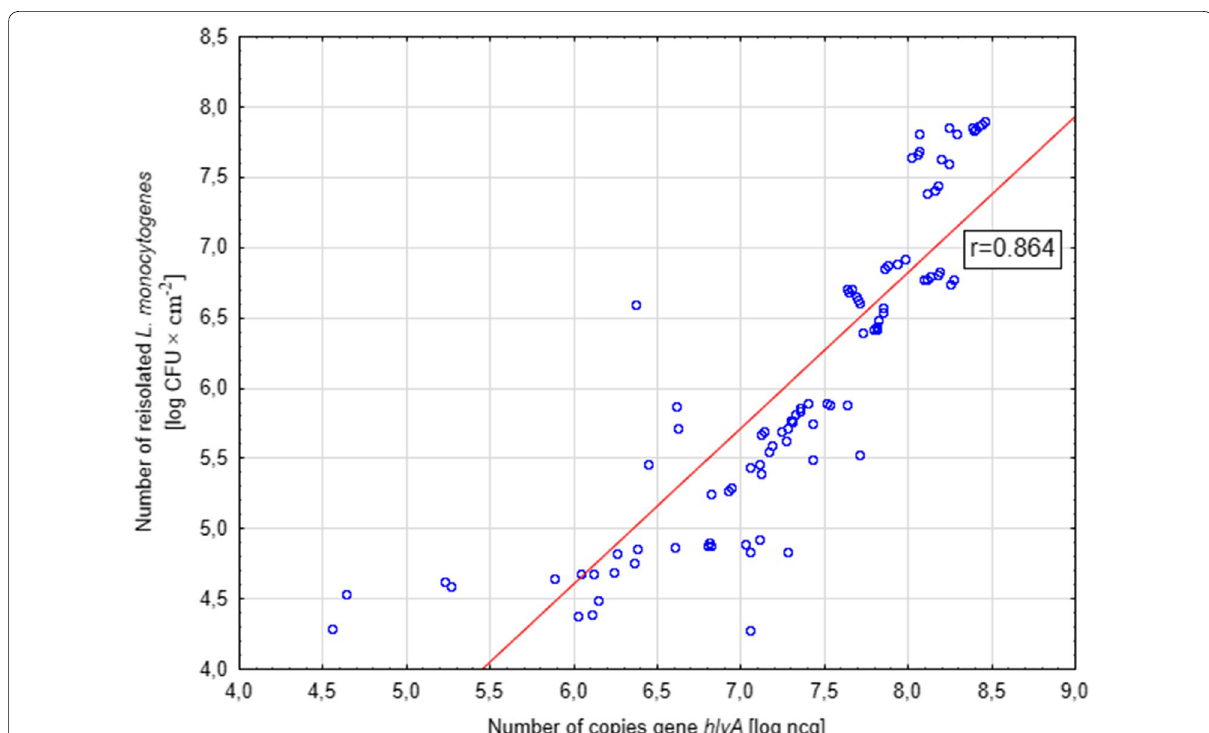
Fig. 3 Correlation between the number of bacteria reisolated from the polypropylene surface and the number of copies of the hlyA gene in the sample for the tested strains of L.